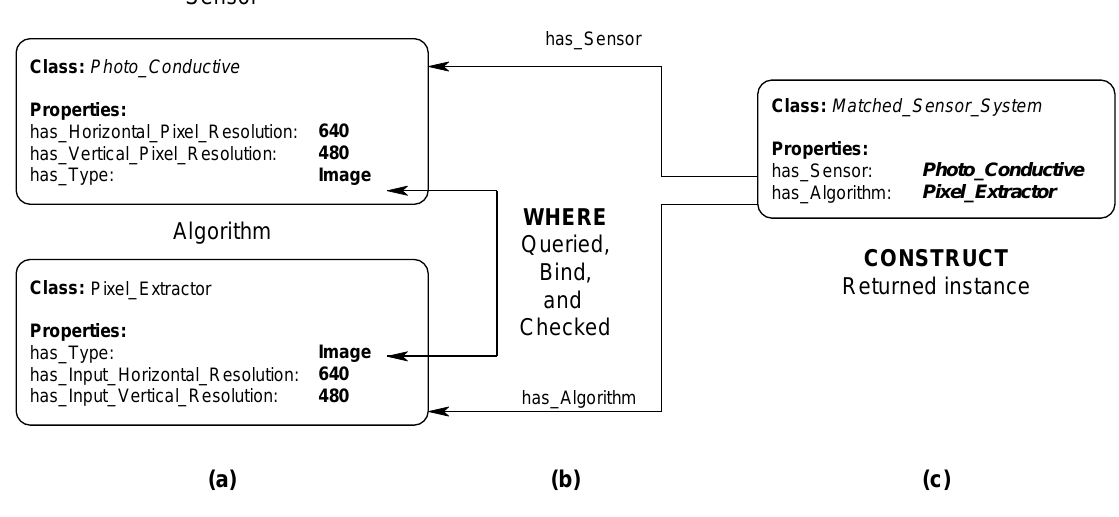
Figure 15. Instance diagram of a SPARQL query binding on specific instance data and returning possible instances (a) Existing Sensor and Algorithm instances that have has_Type values equal to “Image” (b) WHERE clause binding and checking the has_Type property (c) CONSTRUCT clause returning a possible Matched_Sensor_System with established links to the found Sensor and Algorithm